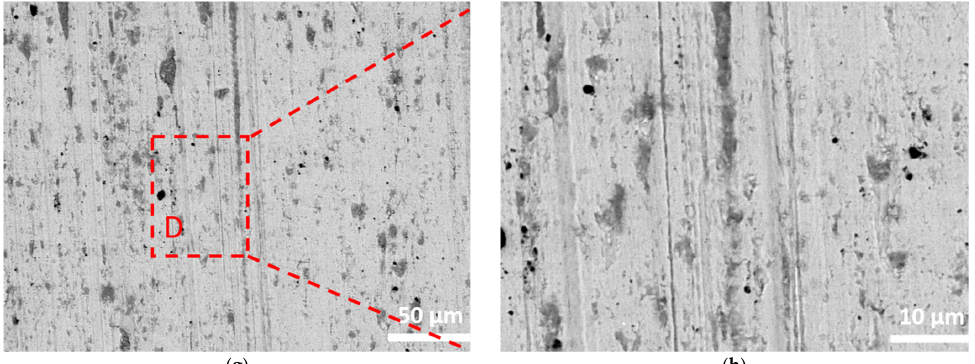
Figure 13. Worn surface morphologies of the iron-based coatings ( a ) 45 A, ( b ) magnification of position A ( c ) 50 A, ( d ) magnification of position B, ( e ) 55 A, ( f ) magnification of position C, ( g ) 60 A, ( h ) magnification of position D.